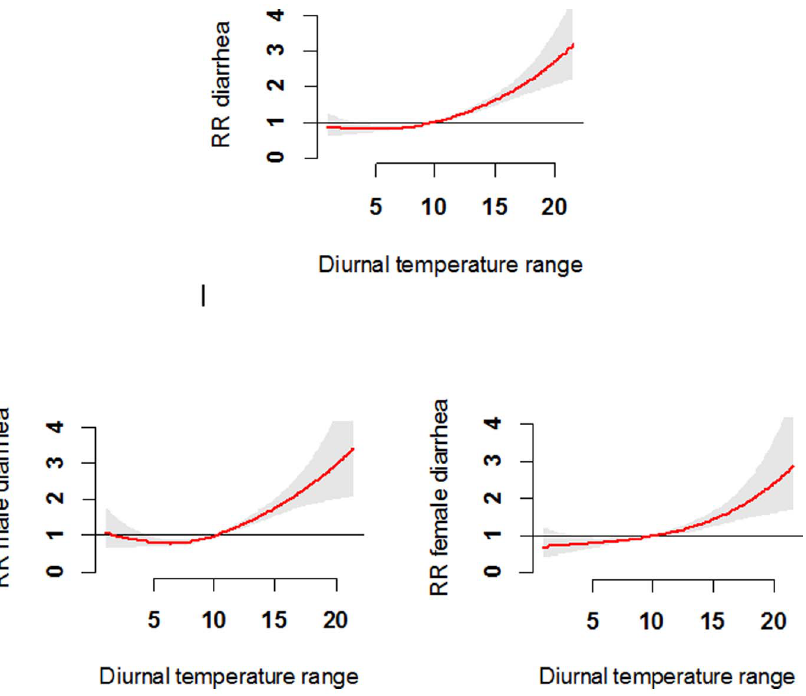
Figure 2. The overall effects of diurnal temperature range on diarrhea among children under five years.